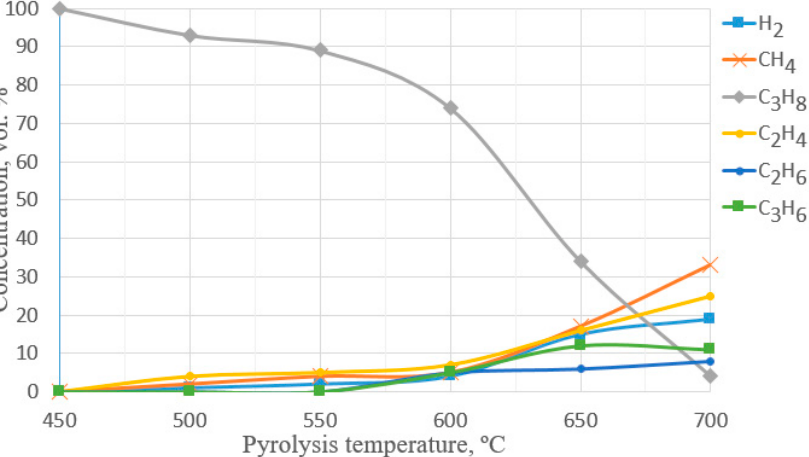
Figure 6. Temperature dependence of non-catalytic propane pyrolysis products concentration using a stirrer, the contact time was around 1 s.